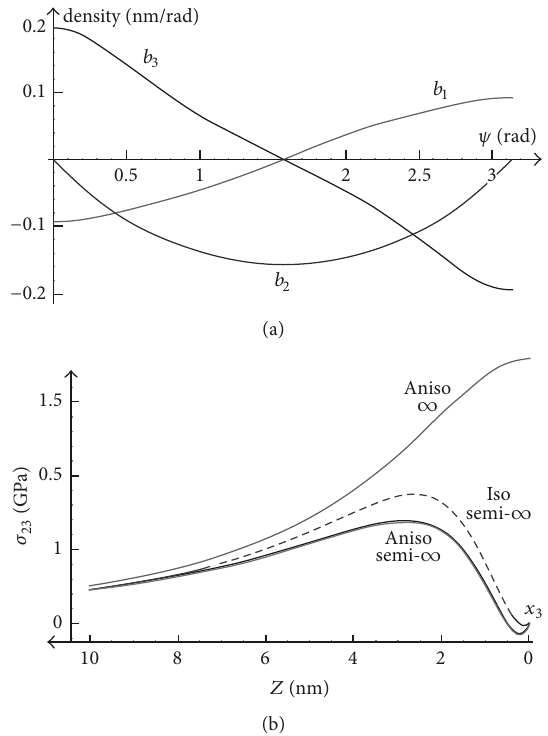
Figure 4: Case of the ( a + c ) screw TD. (a) Change with 𝜓 of the three components of the dislocation density b (𝑏 1 , 𝑏 2 , 𝑏 3 ) in the plane 𝑍 = 0 and (b) evolution of the 𝜎 23 stress component along the straight line ( 𝑋 = 0 , 𝑌 = 2 nm) according to different